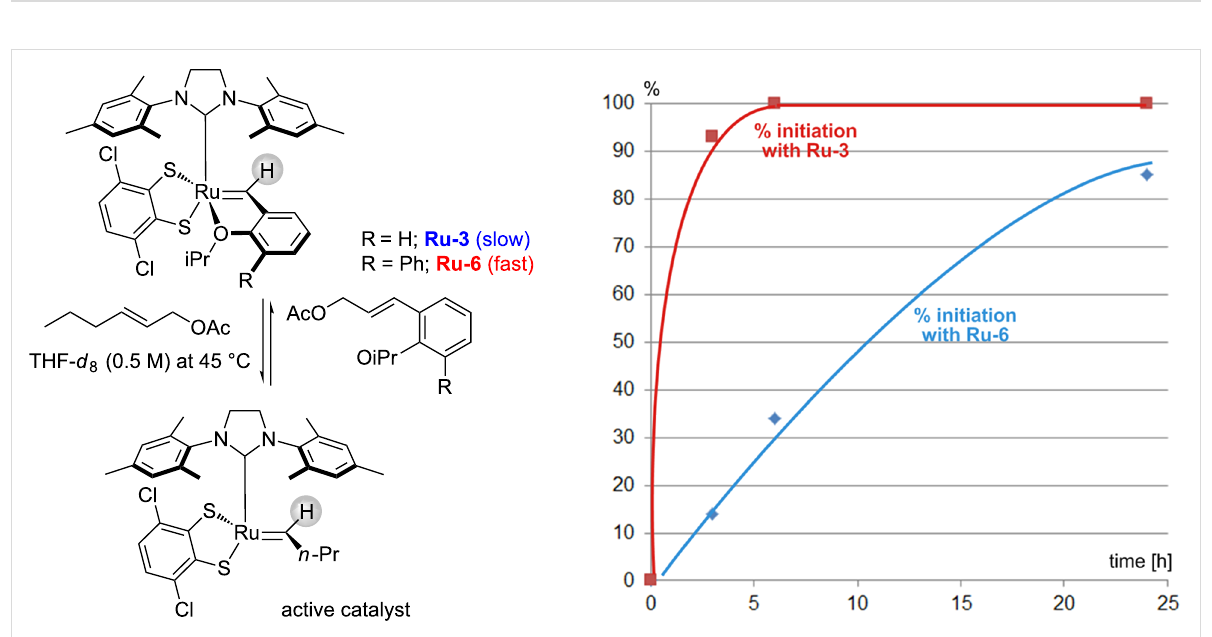
Figure 4: Decrease in the benzylidene signal over time upon reaction with ( E ) - 2-hexenyl acetate.